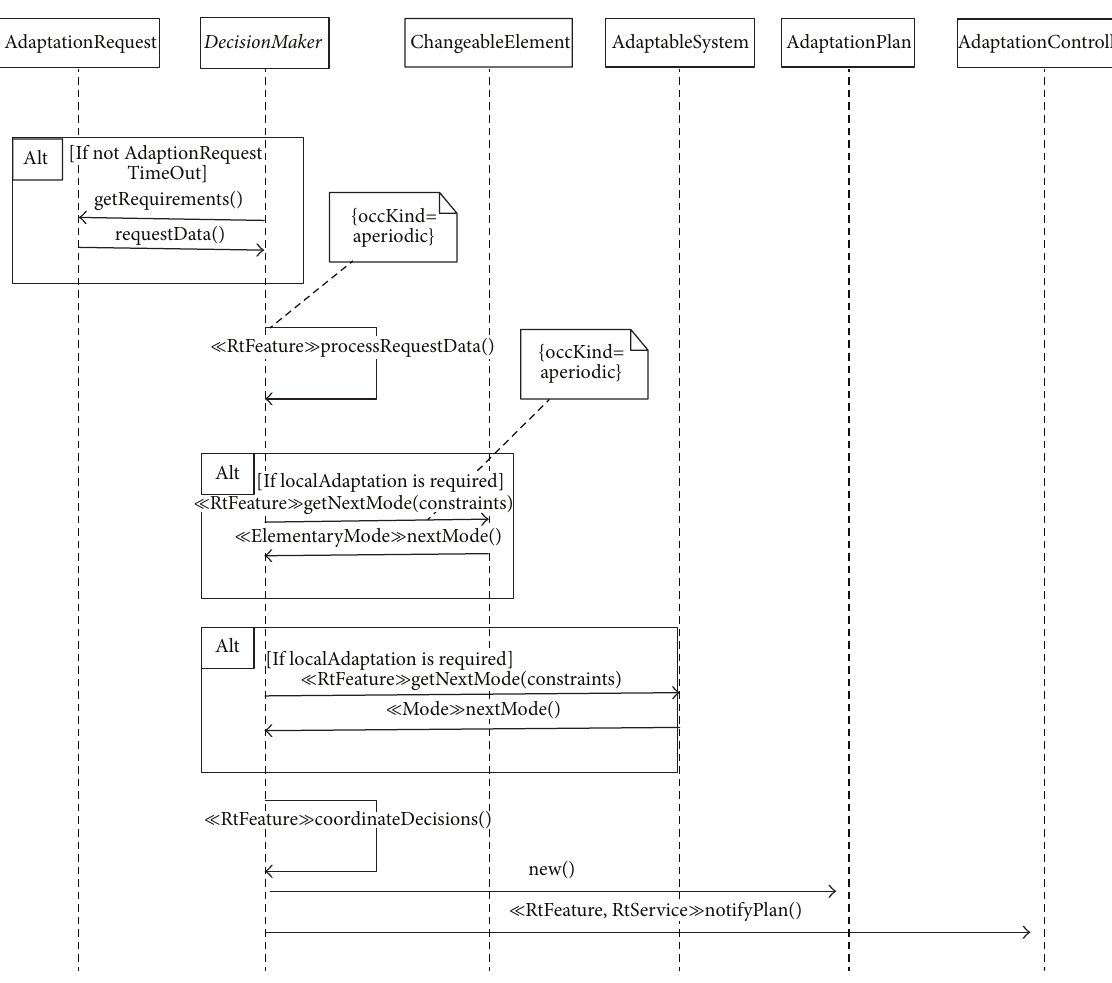
Figure 8: Behavioral view of the RTE DecisionMaker